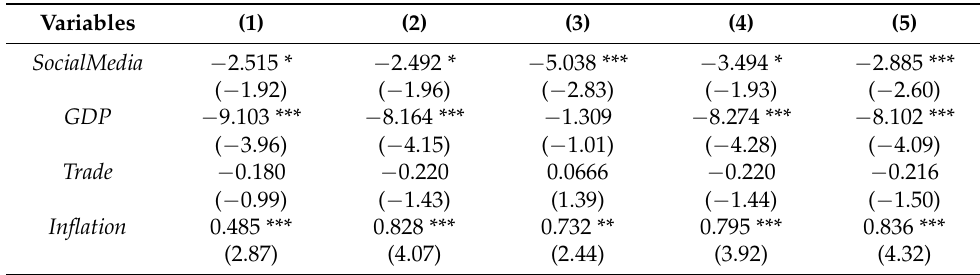
Standard errors are double clustered by country and